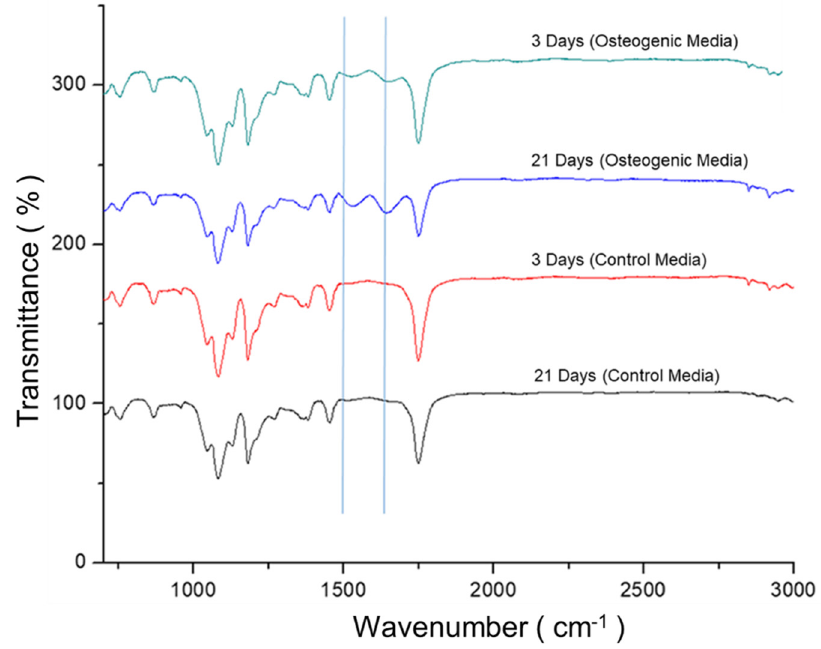
Figure 7. FTIR-IR spectrum of PLA/ZrO 2 scaffolds after 3 and 21 days of culture with hFOB. The PLA/ZrO 2 scaffolds seeded with hFOB cells were cultured with and without the presence of the osteogenic medium. The PLA/0.5 g ZrO 2 scaffold spectrum after 3 and 21 days of culture with osteogenic medium showed new peaks that are characteristic of the amide I and amide II groups at 1650 cm − 1 and 1533 cm − 1 ; the bands that correspond to the PLA are also present.